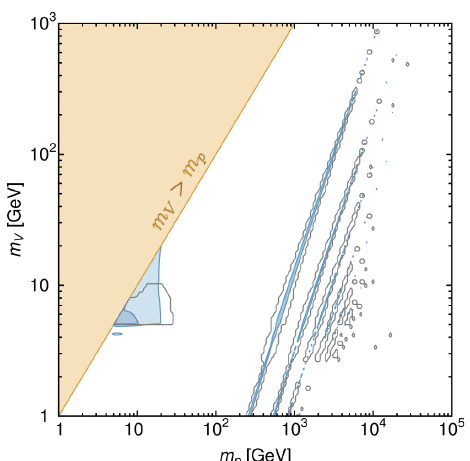
Figure 10: Limits from Fermi-LAT dSphs on DM annihilation in the symmetric limit with equal numbers of p and ¯ p . Shaded regions are constrained. The dark (light) blue region includes (does not include) the profiling over the diffuse background. We = 20 km / s. The have not averaged over the velocity distribution and simply set v rel limits approximately reproduce the constraints from [ 20, Fig. 1 ] shown outlined in gray from an analysis using fifteen dSphs and averaging over the velocity distribution. The details of the analysis together with the number of dSphs used differ so it should not be surprising that the constrained regions do not overlap entirely.